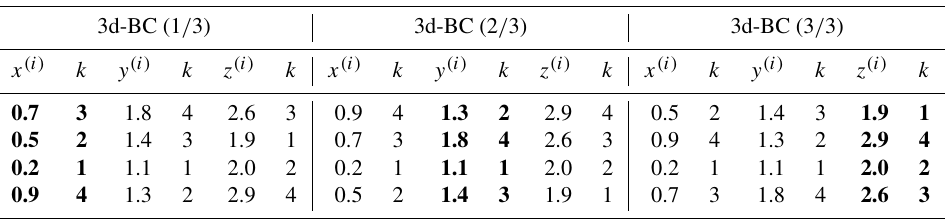
Table 2. Results of the R 2 D 2 correction method. As the initial data are 3-dimensional, three time series are provided by R 2 D 2 . The k indicates the rank within the sample. Within each 3-dimensional time series, the bold values and ranks indicate the dimension and rank sequence taken as